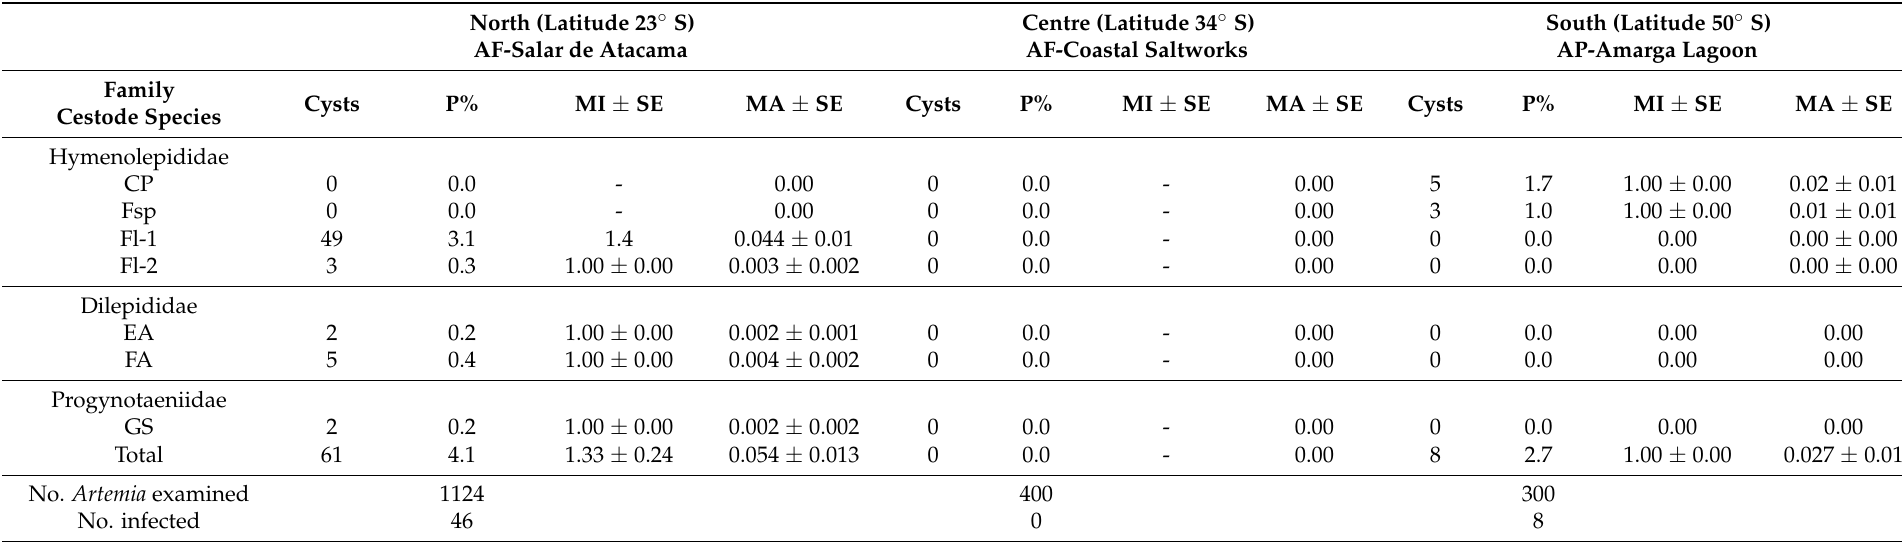
Table 2. Cestode infections in Artemia along a latitudinal gradient in Chile. P%, prevalence; MI, mean intensity; MA, mean abundance; SE, standard error; Cysts, number of cysticercoids. Abbreviations for cestode species are explained in the text. See [15] for additional data for 800 A. persimilis from the south where four cestode species were recorded (CP,